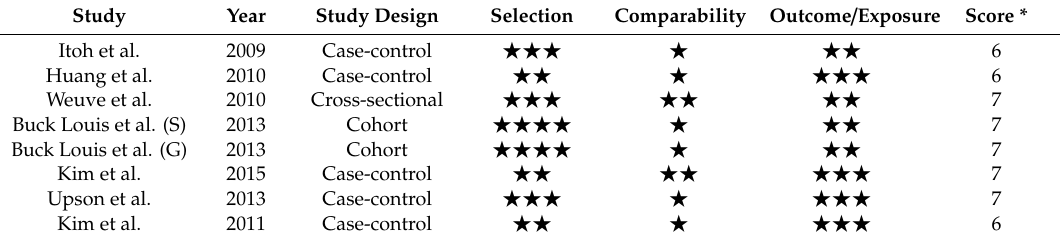
Table 2. The Newcastle-Ottawa quality assessment of included studies.